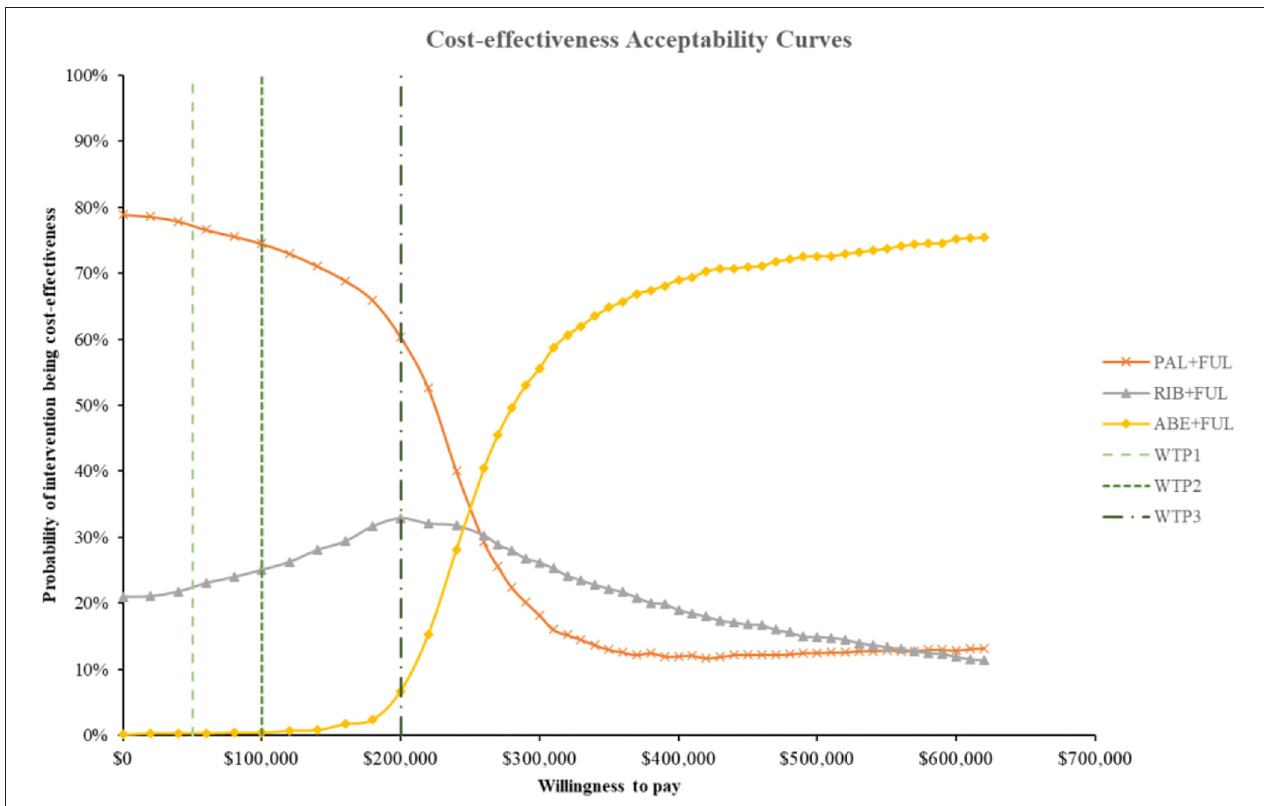
FIGURE 9 | Cost-effectiveness acceptability curves for abemaciclib plus fulvestrant vs. palbociclib plus fulvestrant, ribociclib plus fulvestrant. ABE, abemaciclib; RIB, ribociclib; PAL, palbociclib; FUL, fulvestrant; WTP1, $50,000; WTP2, $100,000; WTP3,